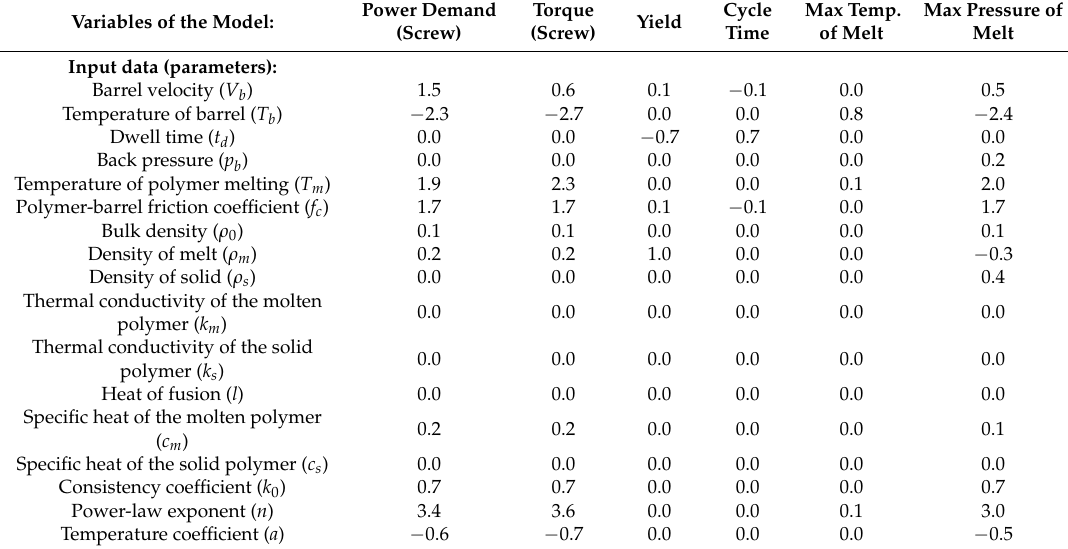
Table 6. The sensitivity test for